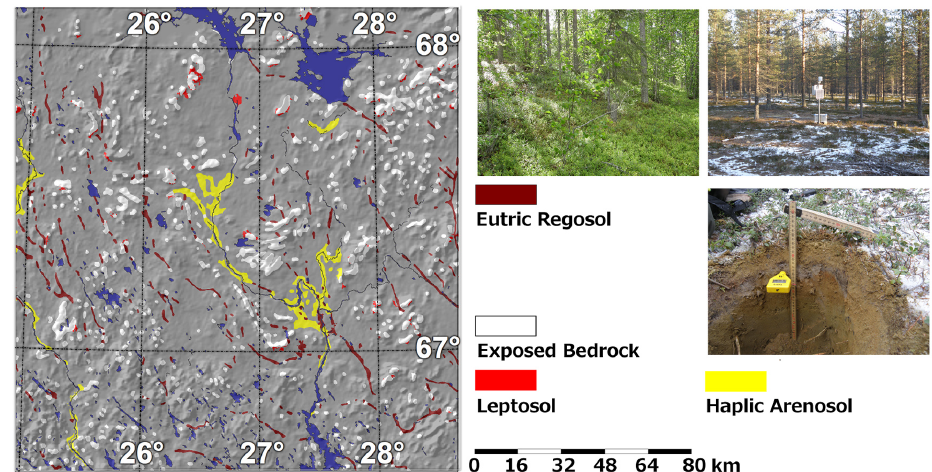
Figure 5. Distribution of other less dominant soils; exposed bedrock, Leptosols, Eutric Regosols and Haplic Arenosols within the Sodankylä region (left panel) and a typical Arenosol top soil profile and vegetation (right panels).